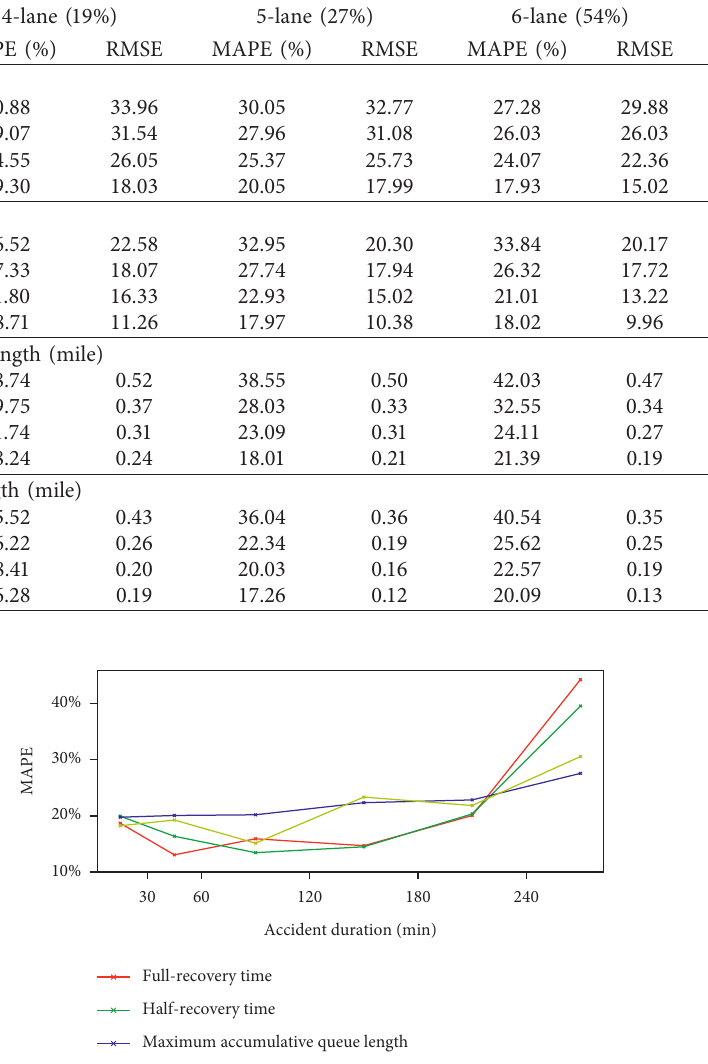
Table 9: Prediction performance comparison of spatial-temporal impact.